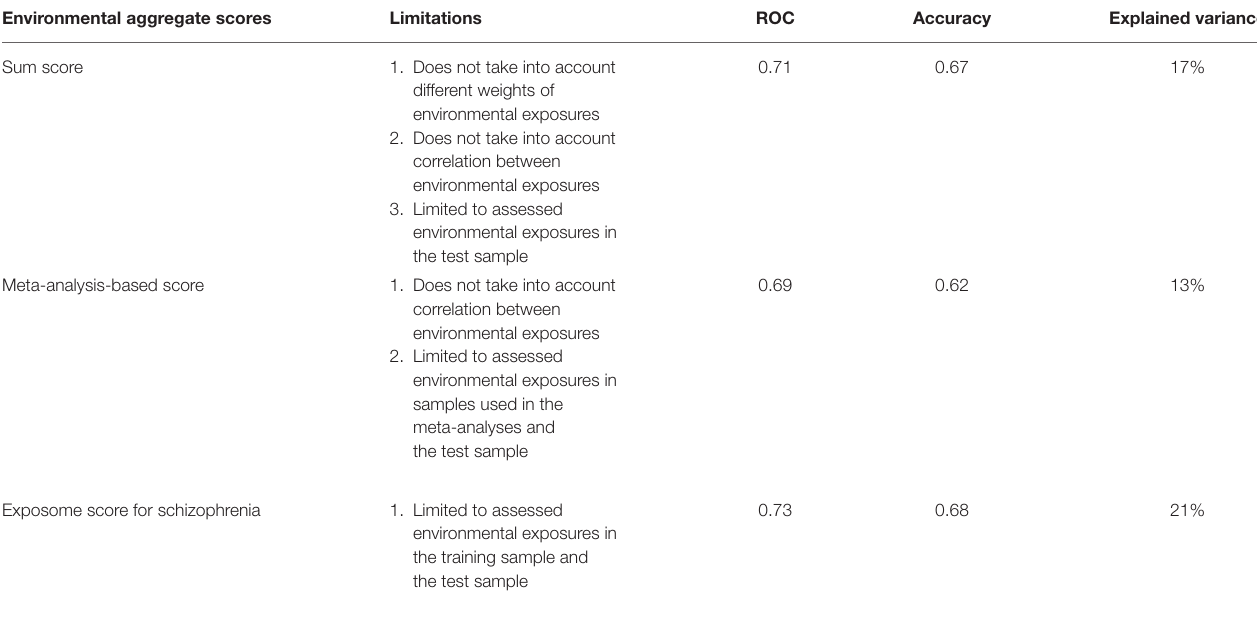
TABLE 1 | overview and comparison of environmental aggregate scores. Environmental aggregate